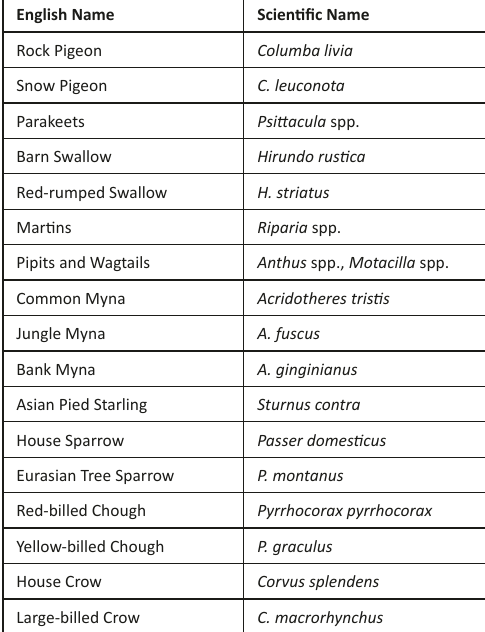
Table 3. List of bird species considered to be superabundant for which different thresholds in terms of numbers are